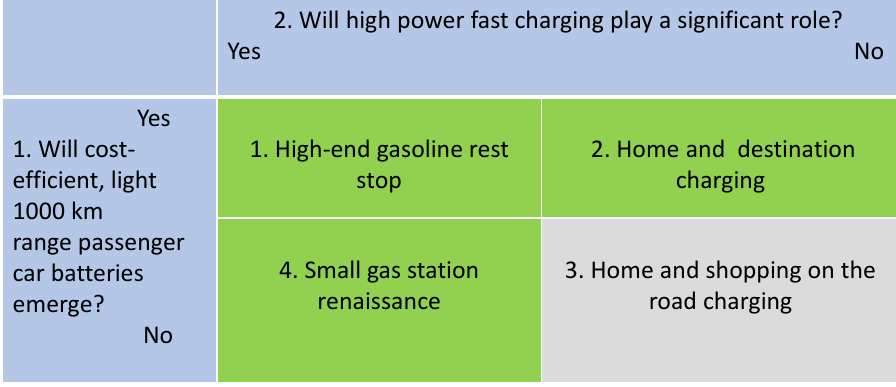
Figure 4. Charging view scenarios.